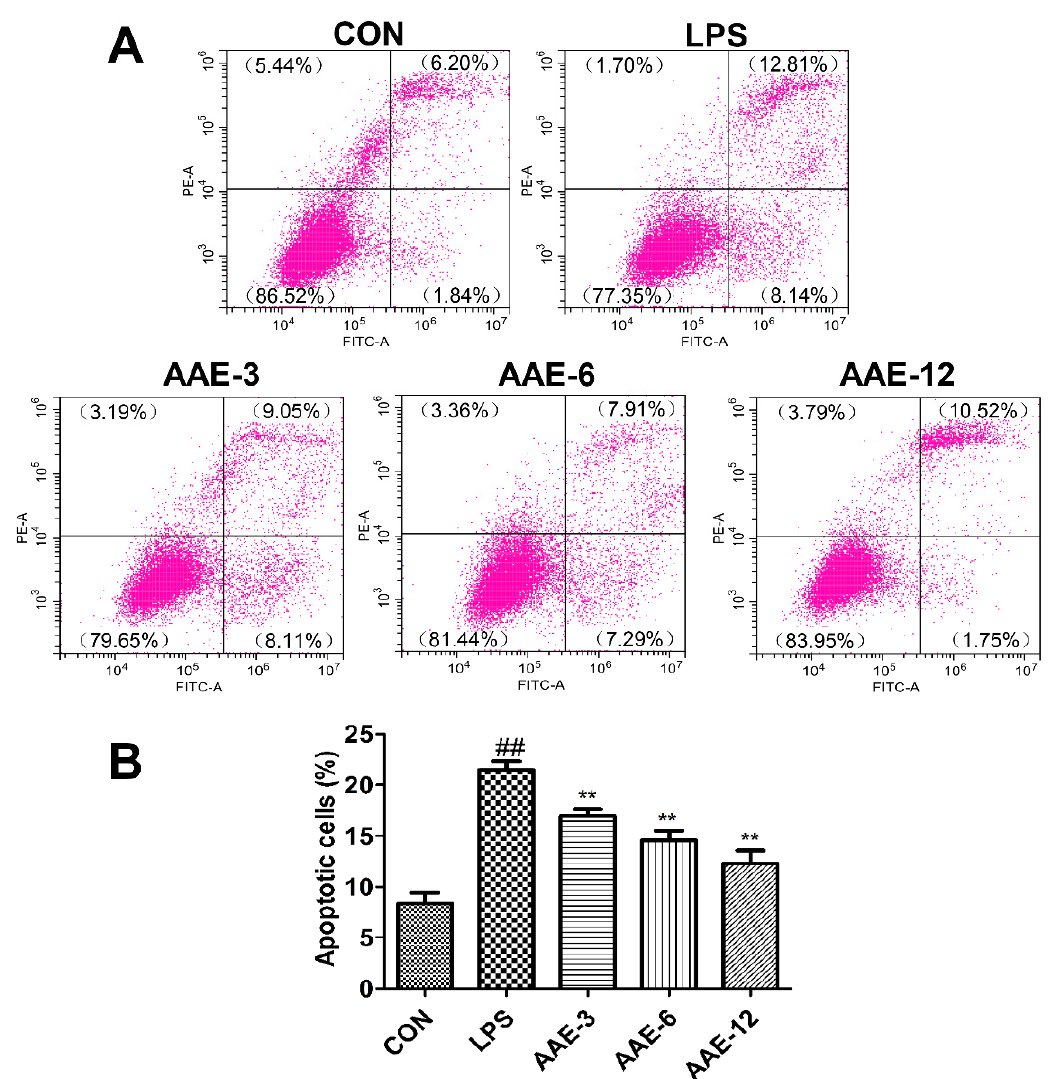
Figure 3. AAE prevented LPS-induced apoptosis. The bMECs were treated in the absence or presence of AAE (3, 6, 12 µ g/mL) for 3 h, and then challenged by 10 µ g/mL LPS for 12 h. ( A ) The percentage of apoptotic cells was detected by flow cytometer. ( B ) Early apoptotic cells and late apoptotic cells (the right two quadrants of each figure in Part A) were added together to compare the percentage of apoptotic cells. CON: cells were cultured in medium (serum-free) for 15 h; LPS: cells were cultured in medium (serum-free) for 3 h and then incubated with 10 μ g/mL LPS for 12 h; AAE-3, AAE-6 and AAE-12: cells were treated with 3, 6 and 12 μ g/mL AAE for 3 h before 10 μ g/mL LPS incubation for 12 h. Comparisons among groups were made with ANOVA followed by Duncan’s test. The data are expressed as mean ± SEM ( n = 3). ## p < 0.01 vs. CON. ** p < 0.01 vs. LPS.